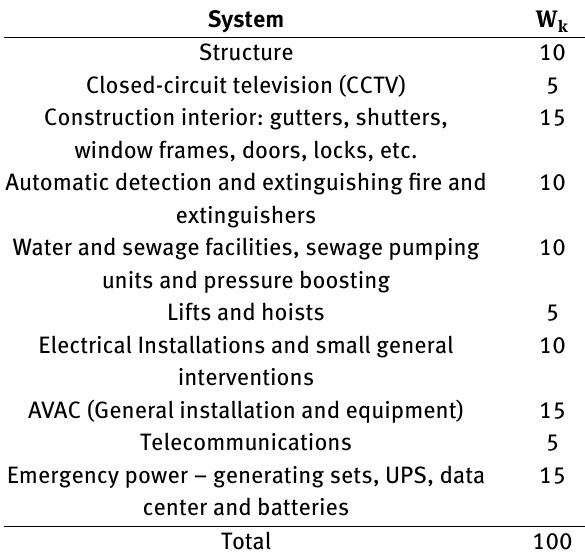
Table 4: Building division into systems and their